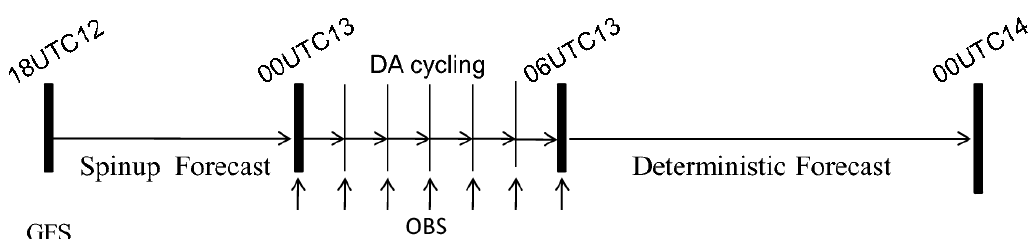
Figure 4. Flow chart of the experiment with data assimilation conducted every 30 min.